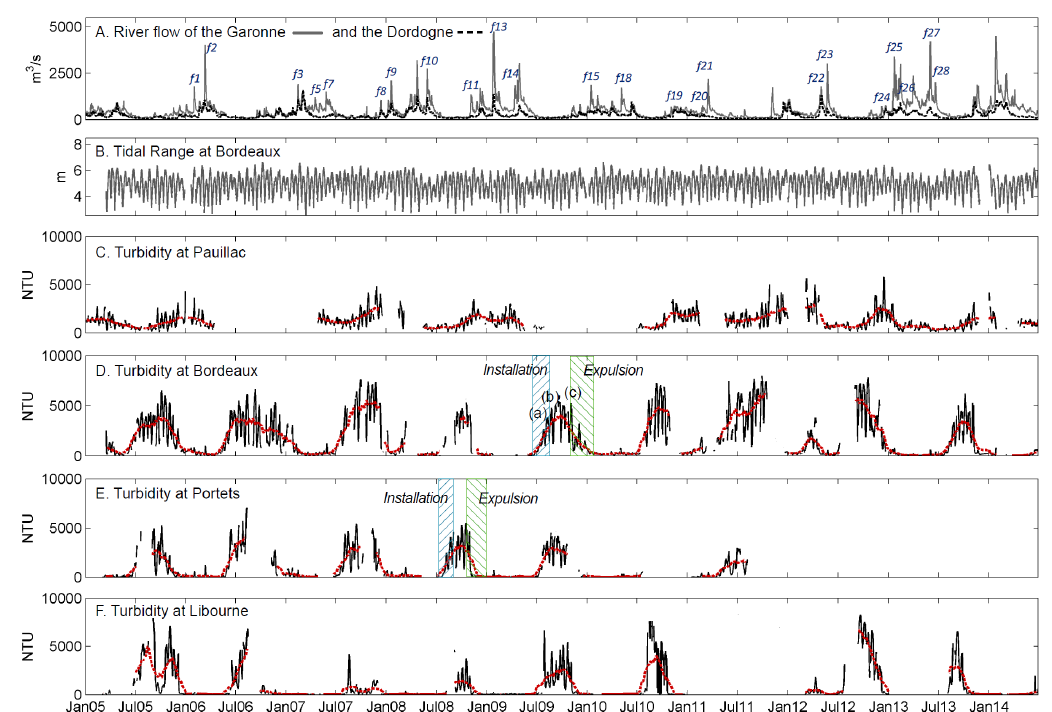
Figure 3. (a) Daily mean flow of the Garonne River and the Dordogne River showing the river flood events of Table 1; (b) tidal range recorded at Bordeaux tide gauge; and tidally averaged turbidity at (c) Pauillac, (d) Bordeaux, (e) Portets and (f) Libourne stations. Red dotted lines represent the low-pass filtered data performed with running averages in order to highlight the turbidity trends. “(f)” plus a number refers to the flood events according to Table 1. “(a)”, “(b)” and “(c)” in panel (d) indicate the neap–spring–neap cycles represented in Fig.